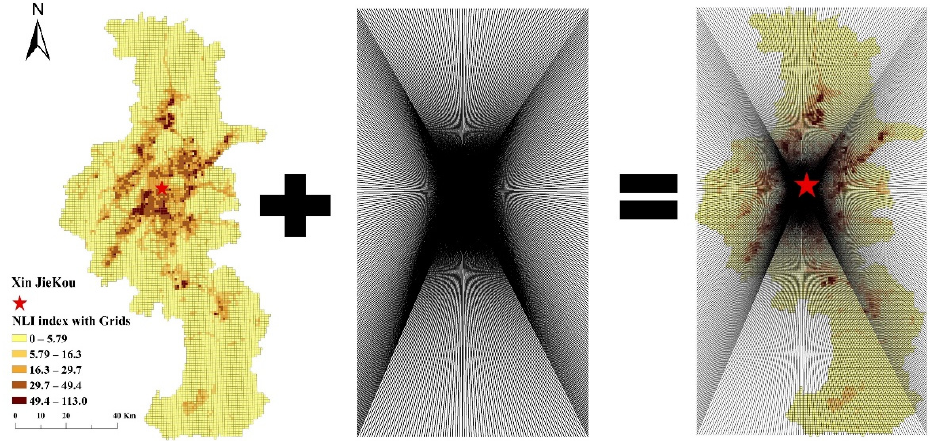
Figure 6. Detecting the mutation points by the sampling lines in 360 orientations. Each sample line’s spatial sequence signal was established by registering the NLI indices of the grids crossing the sample line from the city center to the periphery. The sample line exhibits an apparent urban–rural transition (Figure 7), where the NLI values changed along with the sample line on the map of NLI. The various features of nighttime light crossing the urban fringe region and the outer rural region were described. The sample points with IDs of 1–7 and 18–33, near the city center and located in growth zones, respectively, are in the urbanization–growth step. In the mentioned regions, the utilization types of both urban and rural lands are combined and have a random mosaic structure, leading to the urban infrastructure distributed nonuniformly infrastructure in which lights of nighttime alter. All are related to regional features of urban fringes. The sample points having IDs between 34–46, far away from the center of the city, are less urbanized and include inadequate urban infrastructure, exhibiting low nighttime light, compatible with standard features of rural areas.